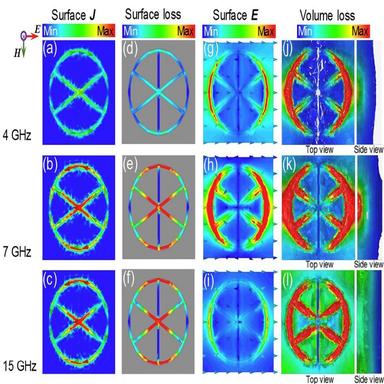
Electromagnetic responses of the designed WMA material under normal incident TM plane waves at 4 GHz, 7 GHz and 15 GHz. (a–c) Vector distributions of surface current density J. (d–f) Scalar distributions of surface loss density. (g–i) Vector distributions of induced surface electric field E. (j–l) Top views (left) and side views (right) of scalar distributions of volume loss density.